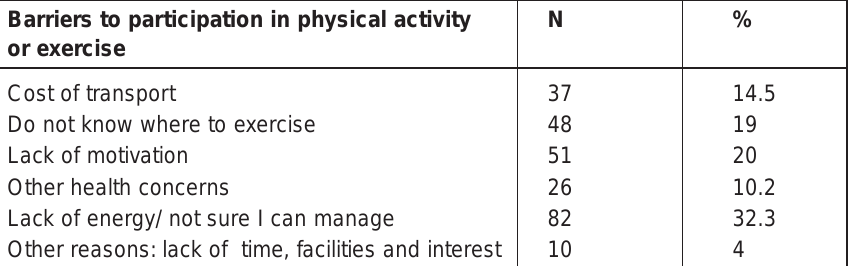
Table 3: Barriers to participation in physical activity or exercise (n=254)